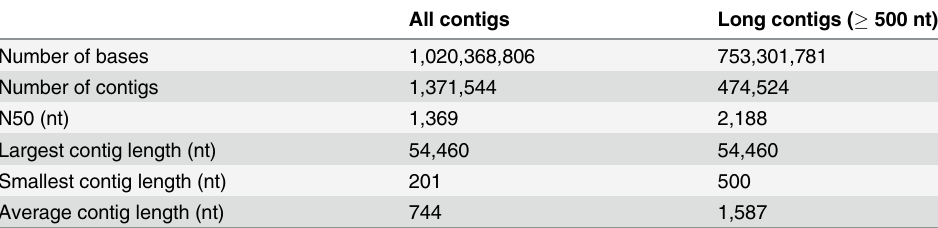
Table 2. Assembly statistics of Illunina paired-end